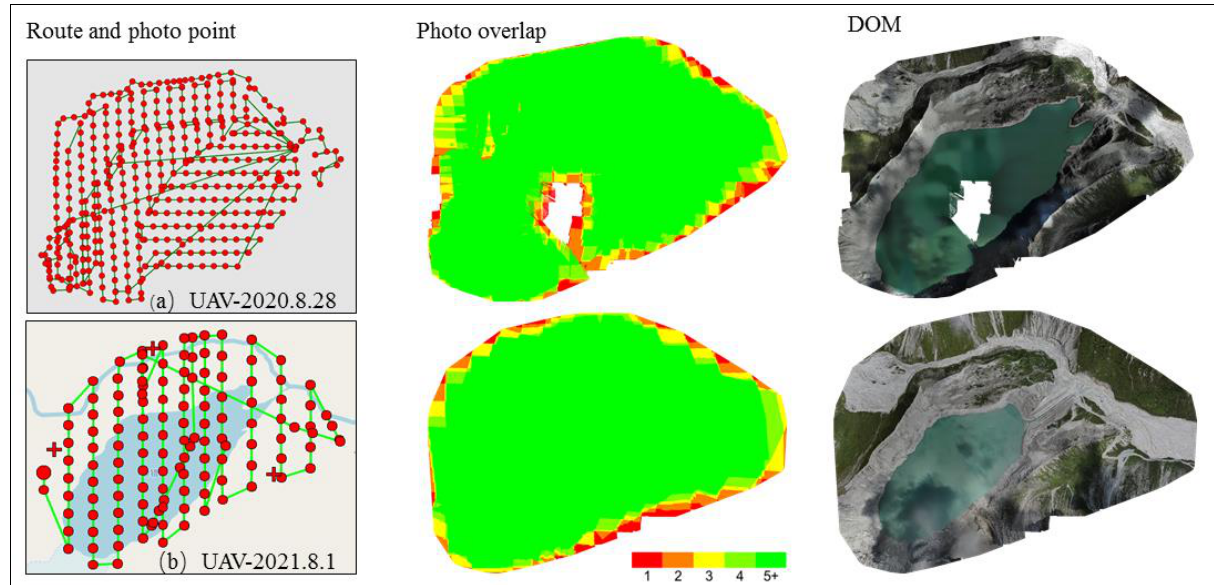
Figure 2. The two UAV aerial survey routes, photo points, photo overlap, and orthophoto display.